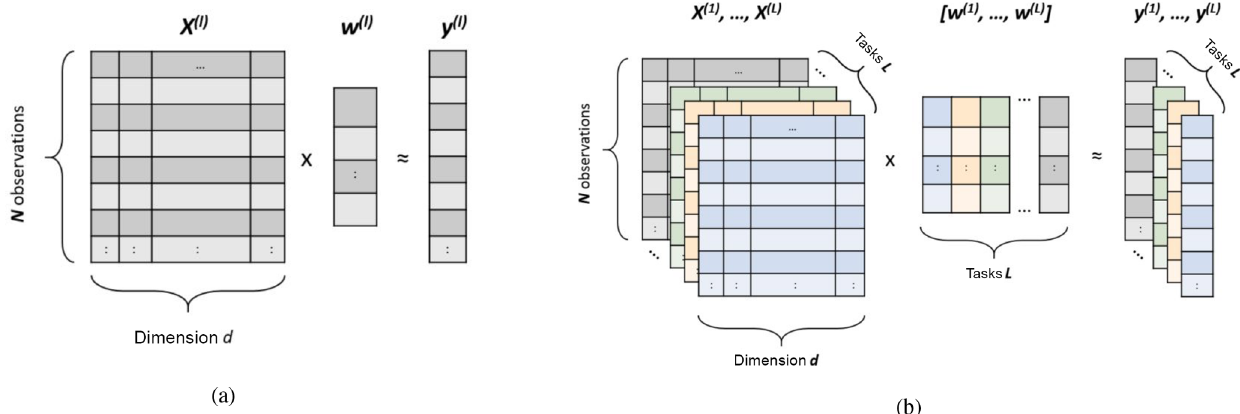
Figure 1. Graphical representation of two learning approaches. (a) A single-task learning approach in which each pixel is treated separately. N d , with N being the number of observations and d being the number of predictors, and a For each pixel l there is an input dataset X (l) R × ∈ N . The vector w (l) d represents the weight vector learned by the model. (b) A multitask learning approach in which target vector y (l) R R ∈ ∈ the models of L tasks are simultaneously learned. The input of the method is the datasets X ( 1 ) , X ( 2 ) , ..., X (L) of all locations (i.e. all global land pixels). The corresponding target vectors are denoted with y ( 1 ) , y ( 2 ) , ..., y (L) . The weight matrix contains the weight vectors for all